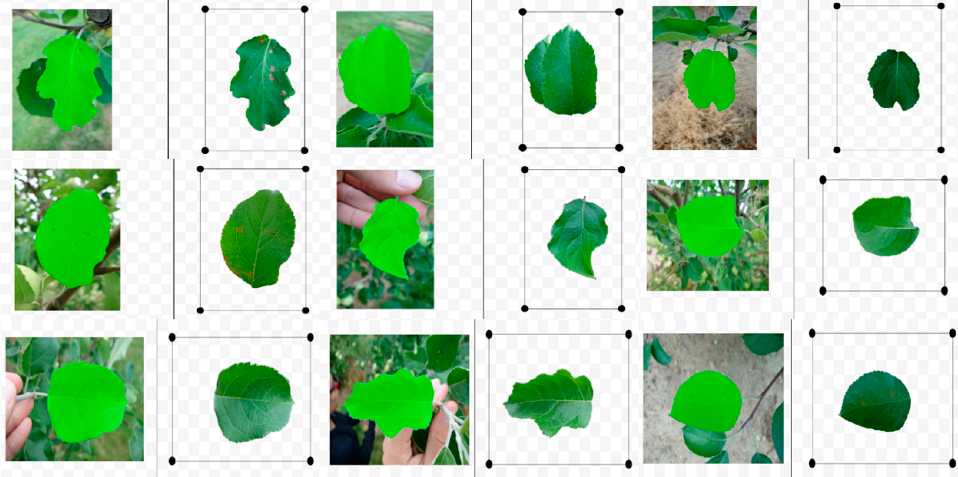
Figure 8. Segmented image and corresponding clean background output image.